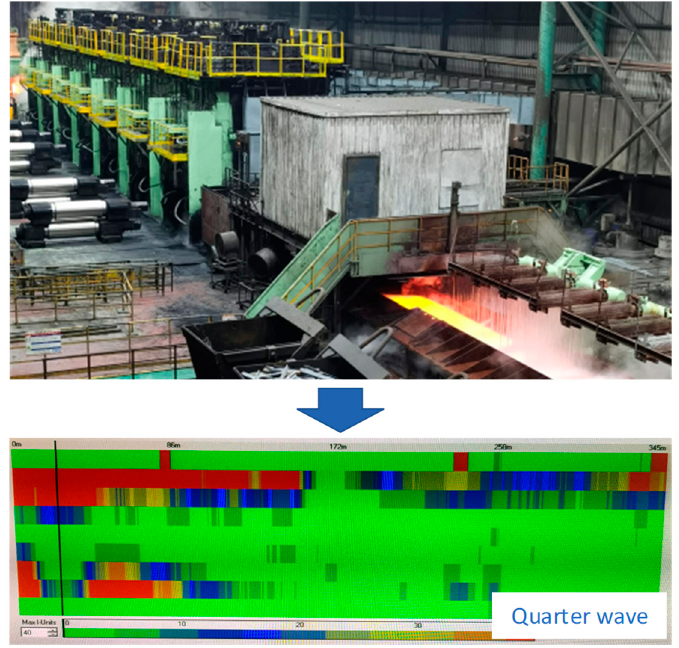
Figure 1. Quarter wave during hot rolling process of high-strength steel.